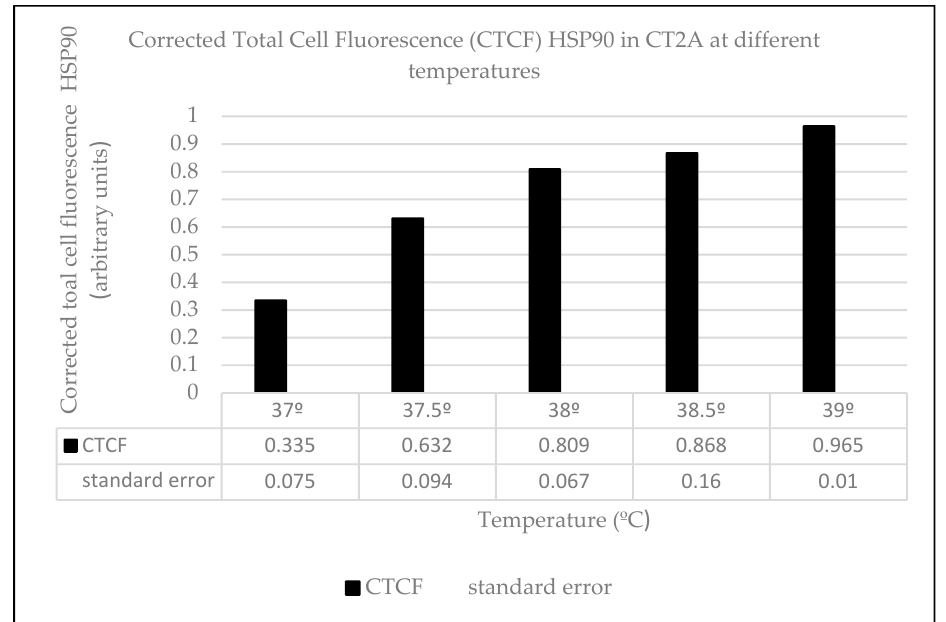
Figure 7. Corrected total cell fluorescence. Average corrected total cell fluorescence (CTCF) of HSP90 expression in CT2A maintained during 1 h and 30 min at 5% CO 2 and different temperatures: 37, 37.5, 38, 38.5, and 39 °C.